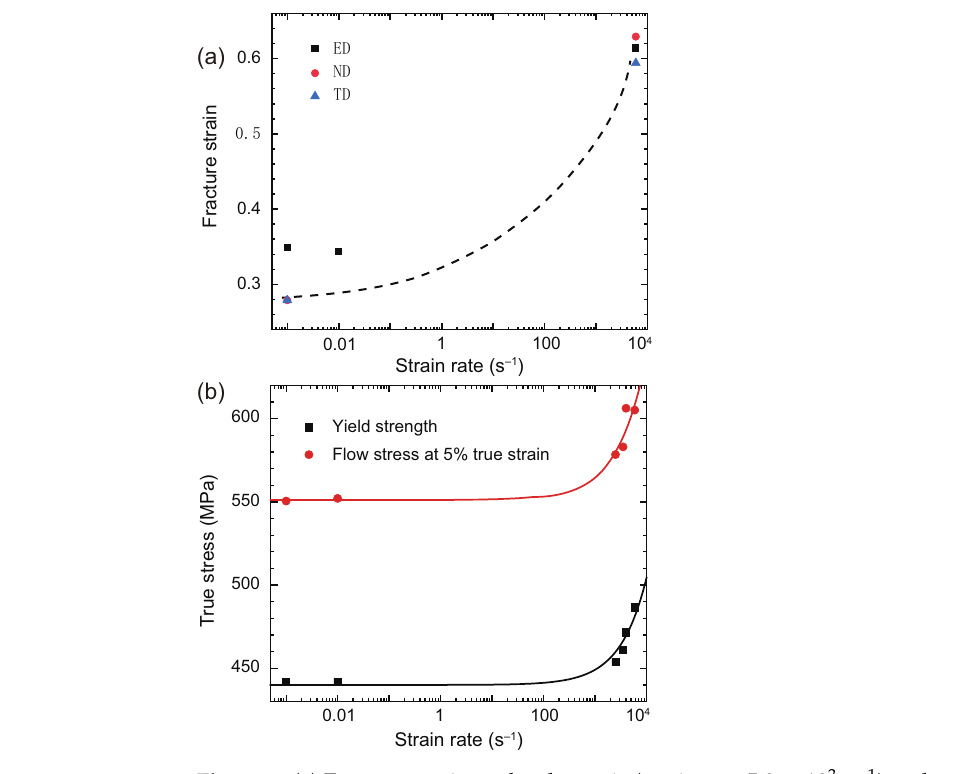
Figure 4. ( a ) Fracture strain under dynamic (strain rate 5.9 × 10 3 s − 1 ) and quasi-static compression along the ED, ND and TD. The dashed curve is guide to the eye. ( b ) Strain-rate dependence of yield stress and flow stress (at 5% strain) under loading along the ED. Table 1. Experimental parameters for CNT/2024Al composite under dynamic and quasi-static compressive